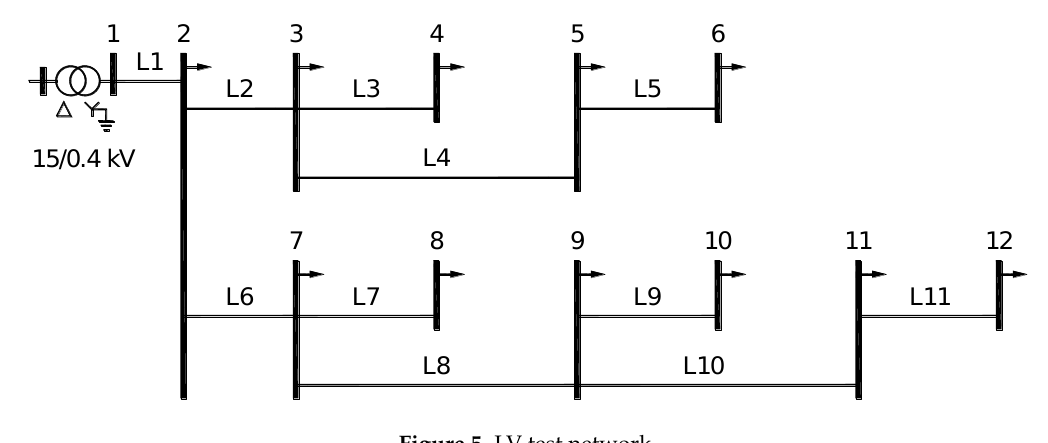
Figure 5. LV test network. Table 1 . Line impedances for the LV test network.